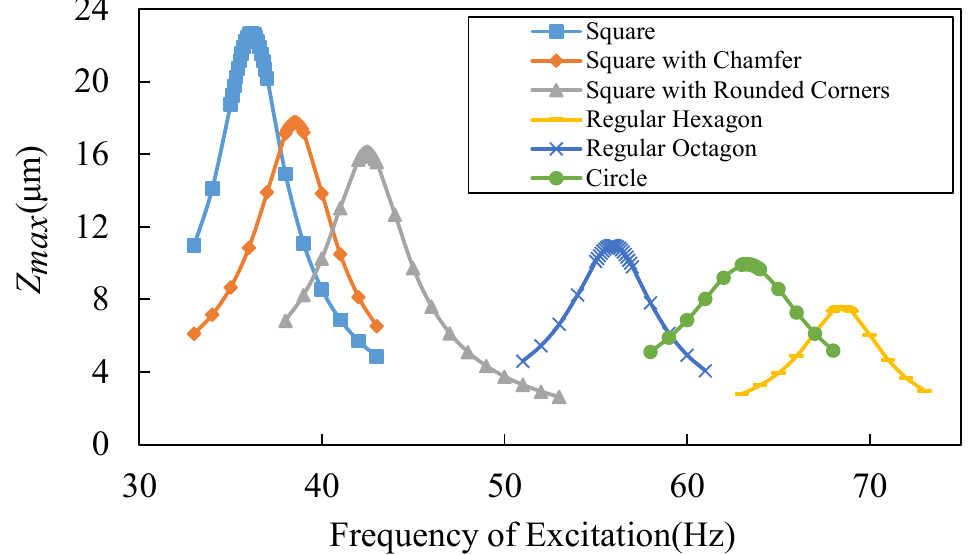
Figure 7. Simulated relative displacement versus different excitation frequency and beam patterns.